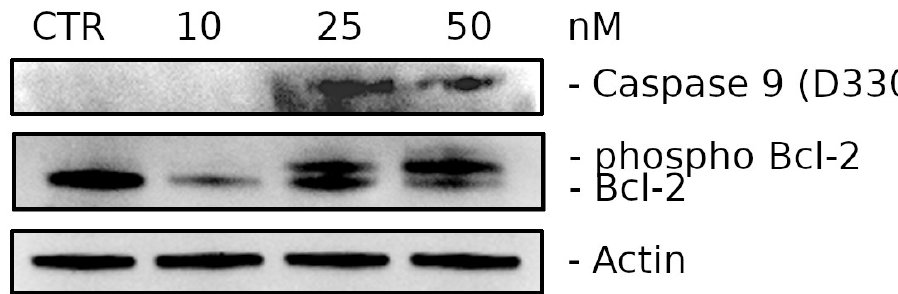
Figure 7. Western blot analysis of Caspase-9 (D330) (Cleaved form) and Bcl-2 levels. HeLa cells were treated for 24 h with 3d at the indicated concentrations.